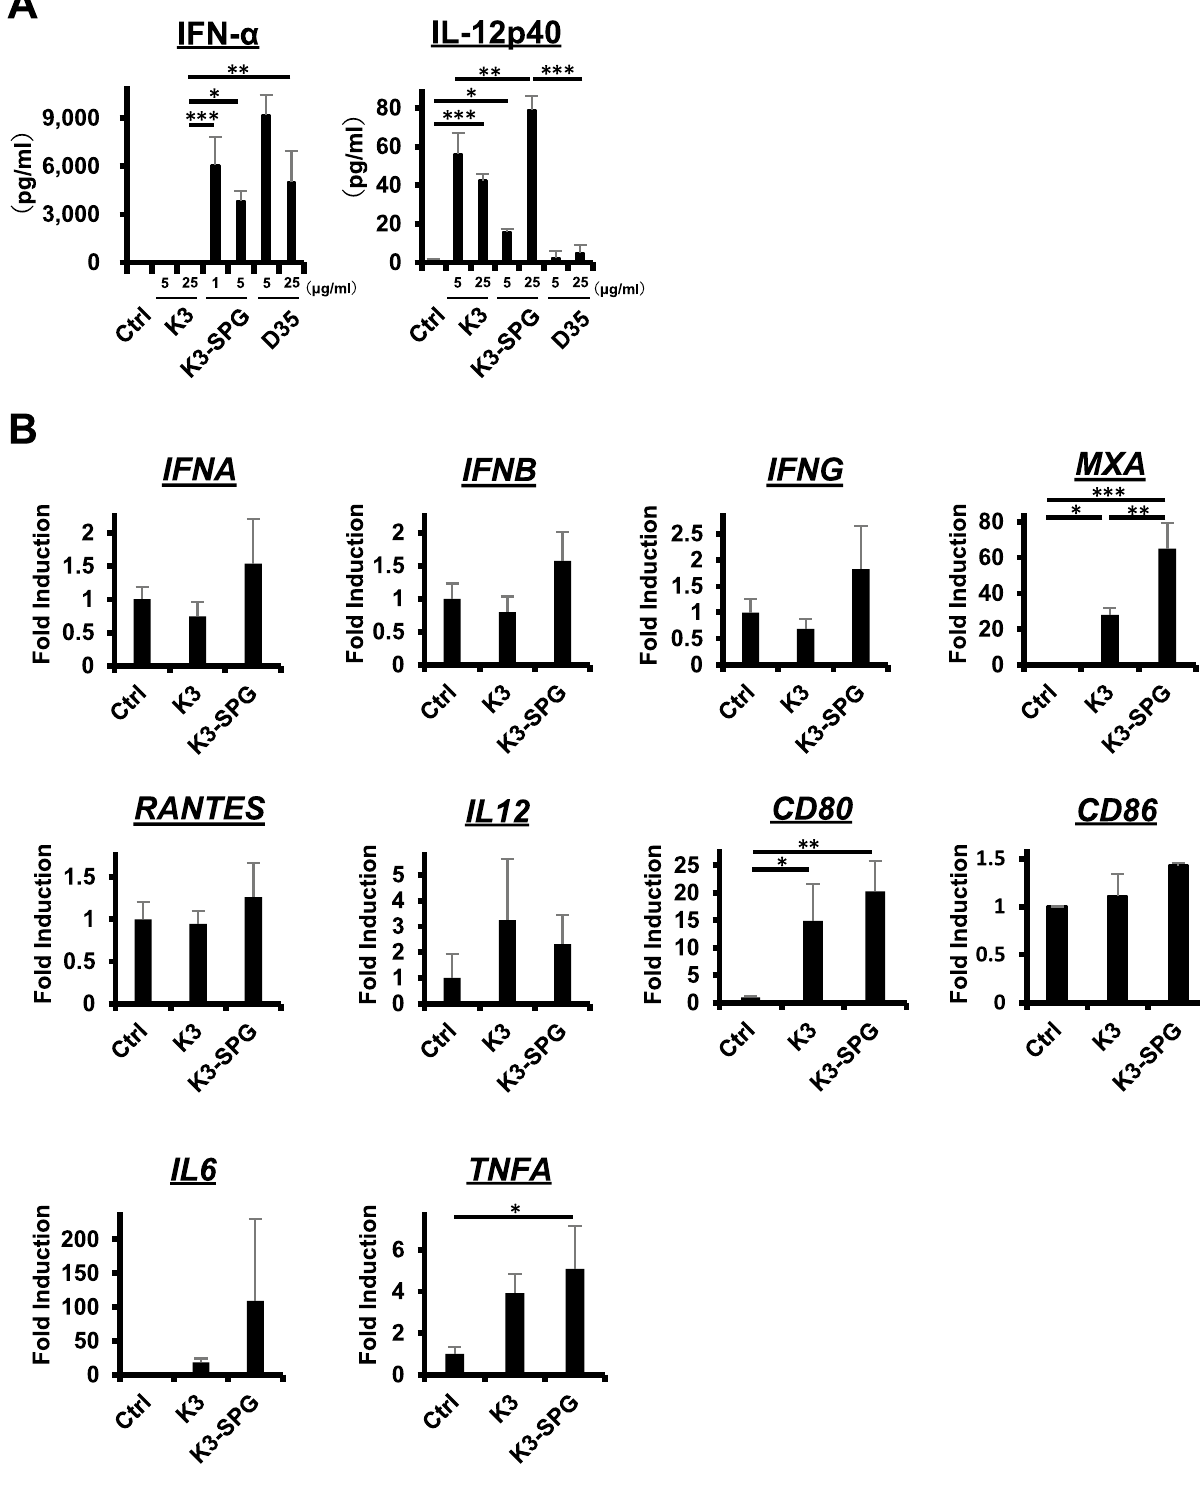
Figure 1. K3-SPG induces type I IFN and Th1 type immune response more potently than conventional TLR9 ligands. ( A ) (Left panel) Production of IFN-α by human PBMC stimulated with K3 (5, 25 μg/mL), K3-SPG (1, 5 μg/mL), and D35 (5, 25 μg/mL) for 24 h was measured by ELISA. (Right panel) Production of IL-12p40 by human PBMC stimulated with K3 (5, 25 μg/mL), K3-SPG (5, 25 μg/mL), and D35 (5, 25 μg/mL) for 24 h was measured by ELISA. ( B ) The relative expression levels of IFNA, IFNB, IFNG, MXA, RANTES, IL12, CD80, CD86, IL6 and TNFA mRNA induced by K3 (5 μg/mL) or K3-SPG (1 μg/mL) were measured by quantitative real-time PCR. The results were normalized to the expression of GAPDH. Data are representative of two independent experiments with similar results. Error bars represent the mean ± SEM. Statistically significant differences were measured by one-way ANOVA followed by the Tukey–Kramer test. * p < 0.05; ** p < 0.01; *** p <